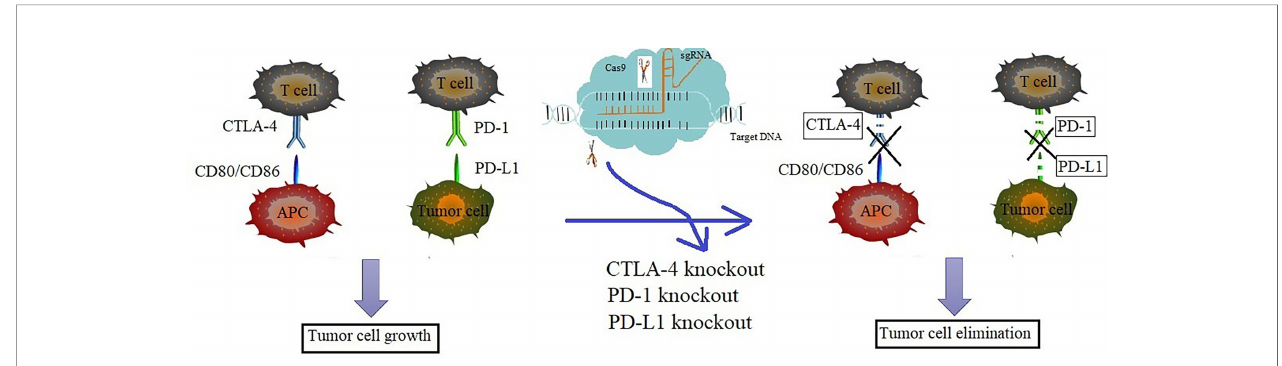
FIGURE 2 | Knockout of PD-1/PD-L1 or CTLA-4 via CRISPR/Cas9 enhanced the anti-tumor immune response. The increased level of PD-1 in T cells, PD-L1 in tumor cells and CTLA-4 in APC cells may cause acquired immune resistance and attenuates the function of CTLs. The depletion of PD-1, PD-L1 or CTLA-4 via CRISPR/Cas9 technology could overcome the cancer immune resistance and enhance cancer immunotherapy effect. Blue represents the progress of immunotherapy, while pink represents the progress of CRISPR/Cas9 technology. The mixed color represents the key studies of the combined two